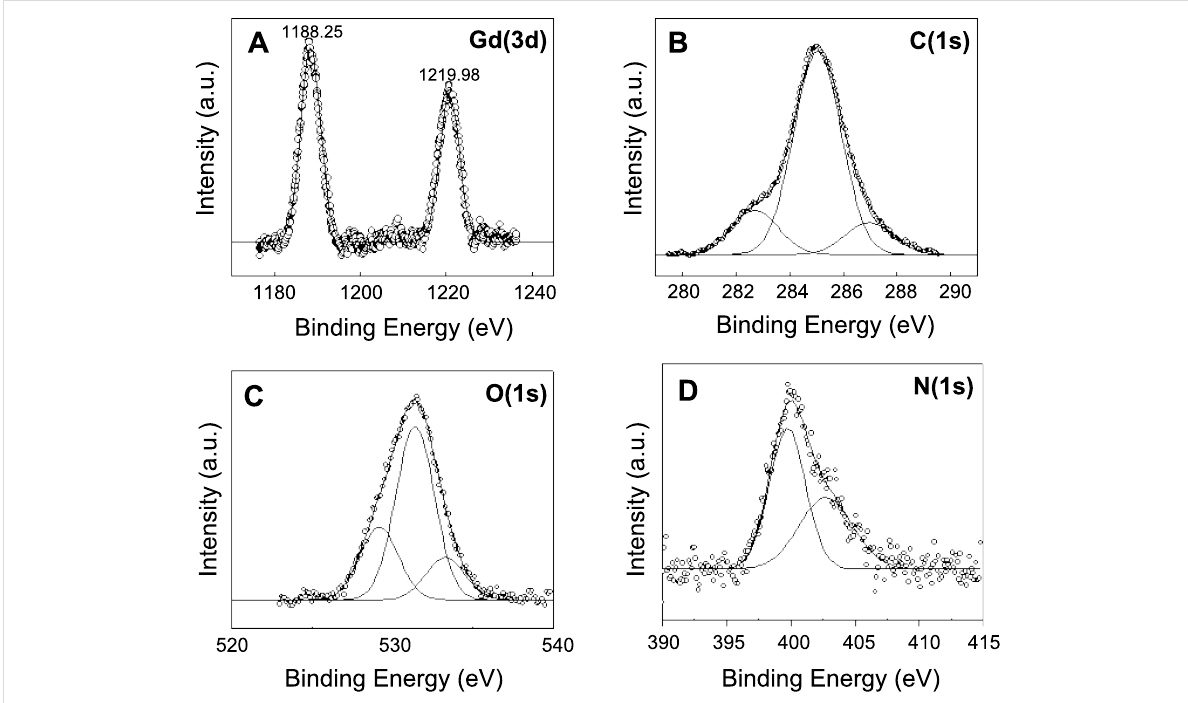
Figure 4: XPS data showing the (A) Gd(3d), (B) C(1s), (C) O(1s) and (D) N(1s) core level spectra recorded from biosynthesized Gd 2 O 3 nanoparticles film cast onto a Si substrate. The raw data are shown in the form of symbols, while the chemically resolved components are shown as solid lines and are discussed in the text.